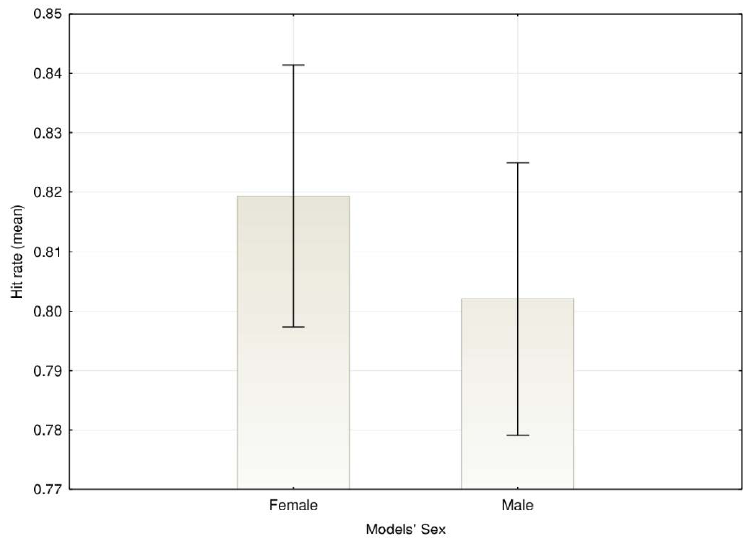
Figure 2. Mean agreement rates for the emotion recognition depending on the models’ sex (error bars represent 95% CI).